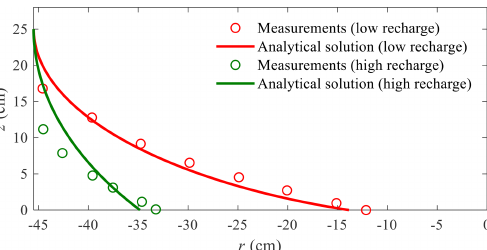
Figure 3. Comparison between analytical and experimental (data compiled from Memari et al., 2020) results for the freshwater– seawater interface location for different recharge events. Note that the left and right sides are the sea and internal no-flow boundaries, respectively.